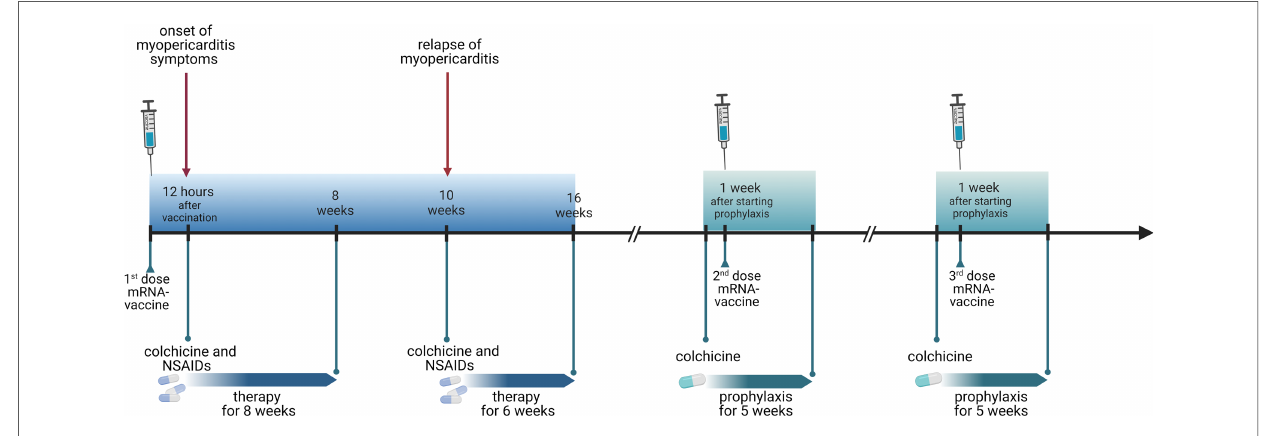
FIGURE 2 Timeline of clinical course ( fi gure created with